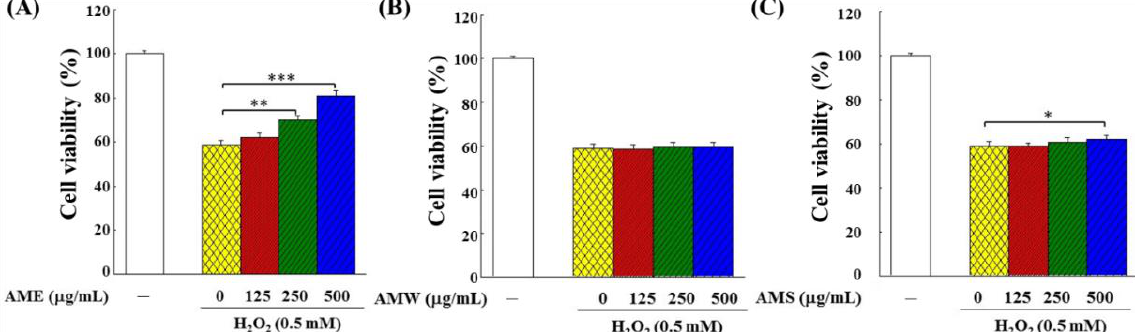
Figure 4. Protective effects of AMf extracts (( A ) AME, ( B ) AMW and ( C ) AMS) on growth of PC12 cells under the H 2 O 2 stimulation in Treatment mode. PC12 cells were first cultivated for 24 h, stimulated with 0.5 mM H 2 O 2 for 4 h, then treated with specific extract for 24 h, and the viability was analyzed with an MTT kit. The control group was the cells grown without H 2 O 2 stimulation and extract sample treatment, and the cell number of this group was set as 100%. This experiment was repeated five times. The significance of the difference in data compared to the vehicle are labeled as * p < 0.05, ** p < 0.01 and *** p < 0.001.